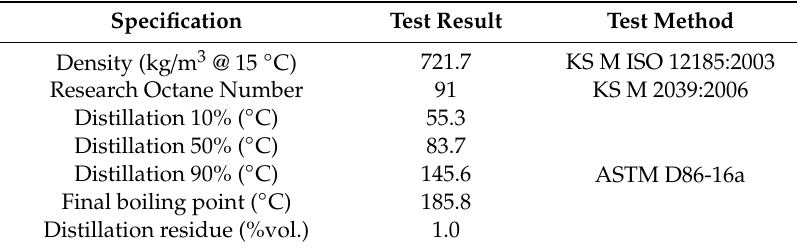
Table 2. Properties of tested gasoline